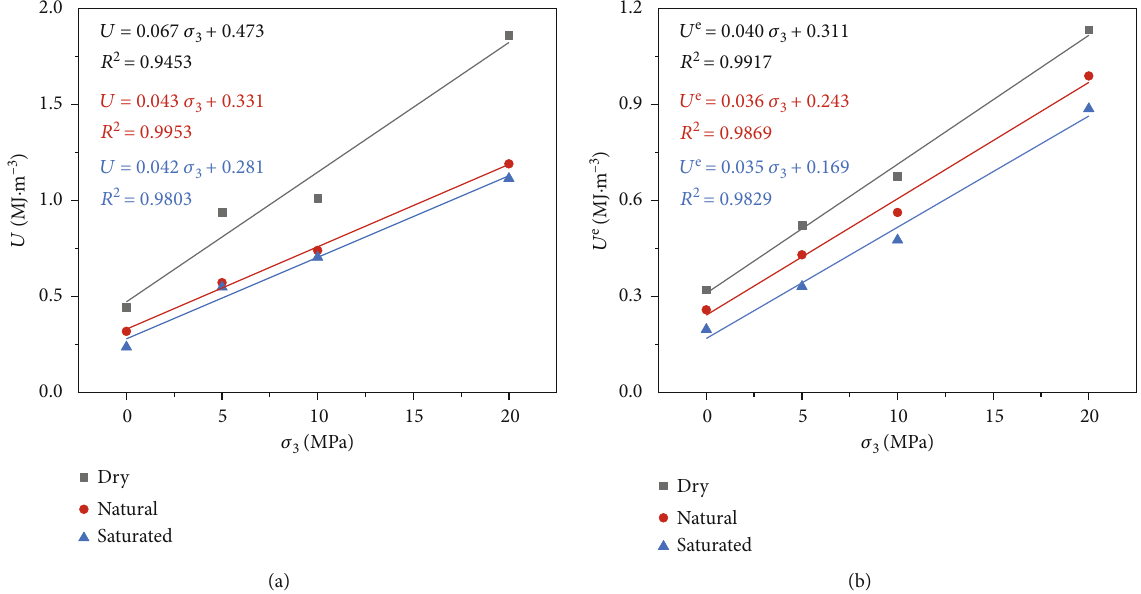
Figure 10: Relationship between the total input energy and elastic strain energy at peak point and con fi ning pressure: (a) total input energy; (b) elastic strain